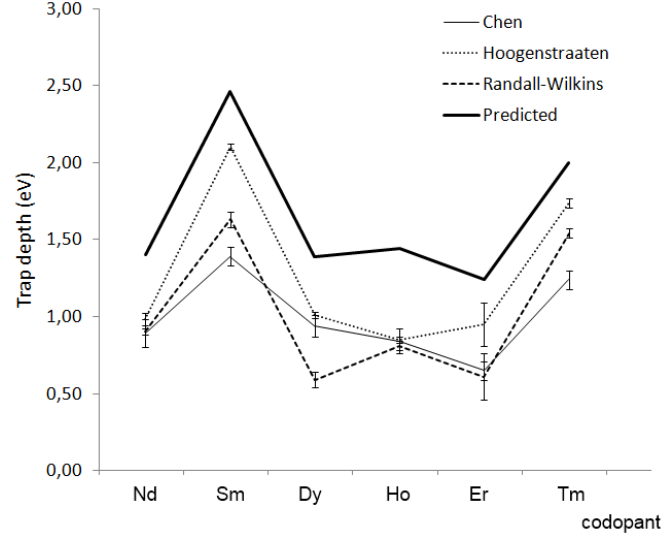
Figure 13. Trap depths in YPO :Ce 3+ codoped with various lanthanides, as predicted by 4 the Dorenbos energy level scheme and estimated from thermoluminescence measurements (data taken from